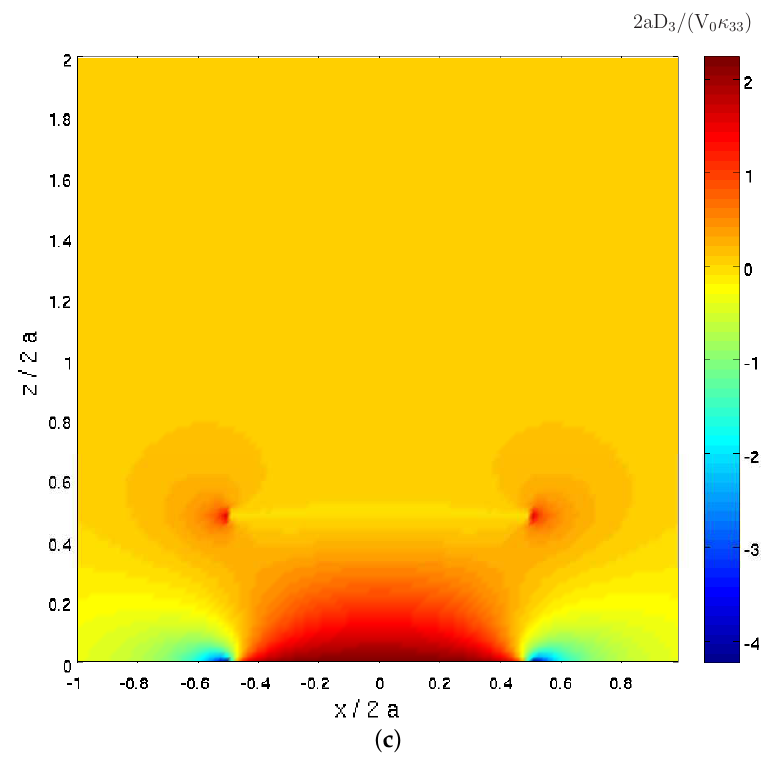
Figure 4. A piezoelectric (PZT-7A) half-plane attached to an electrode of electric potential V 0 at z = 0 with a defect in the form of a short crack. ( a ) The variations of the induced normal stress σ 33 and electric displacement D 3 along the crack line at z / a = 1. ( b ) The distribution of the induced normal stress σ 33 in the region − 1 ≤ x /2 a ≤ 1, z /2 a ≤ 2. ( c ) The distribution of the normal electric displacement D 3 in the region − 1 ≤ x /2 a ≤ 1, z /2 a ≤